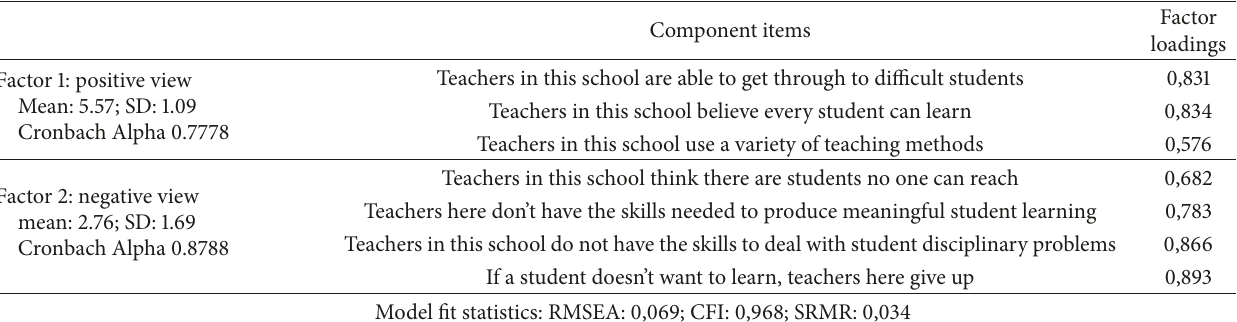
Component items